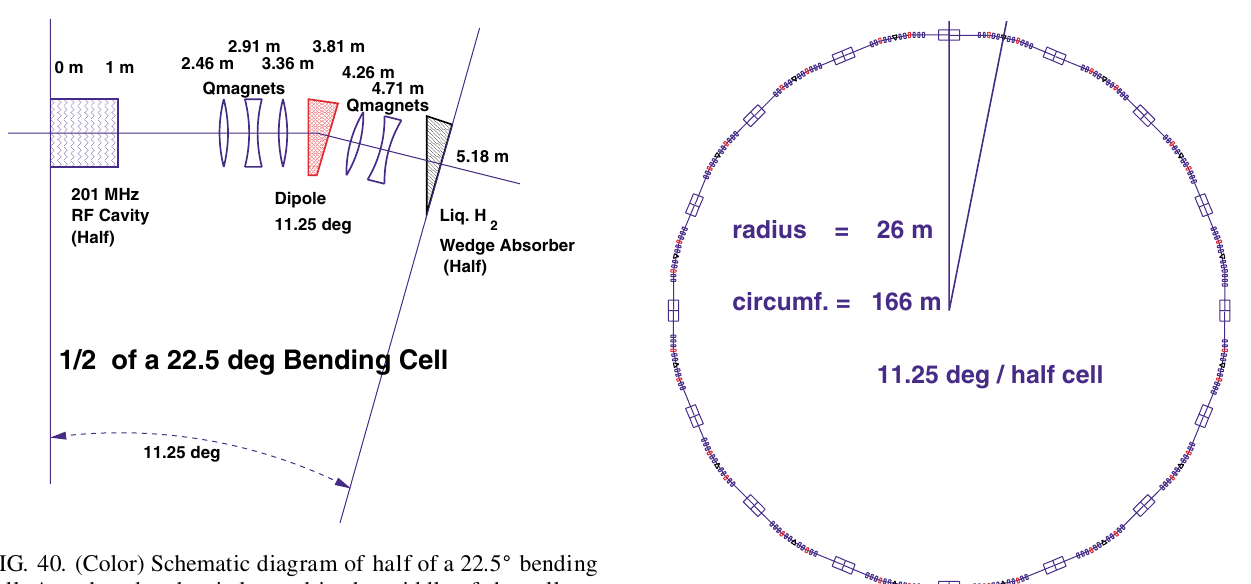
FIG. 41. (Color) The @ bending cell. SYNCH calculations (solid curves) and beam parameters from an ICOOL simulation (marked points) are